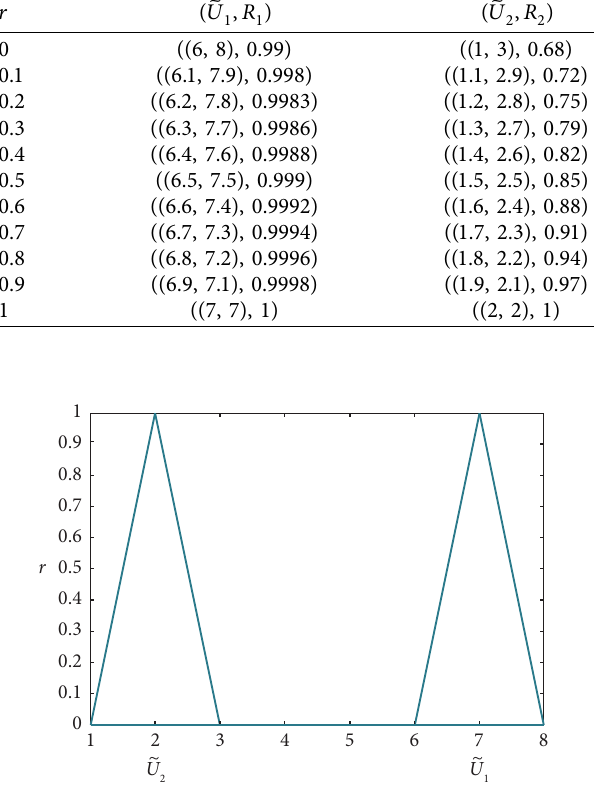
Figure 5: Chart of the restriction part of 􏽥 U